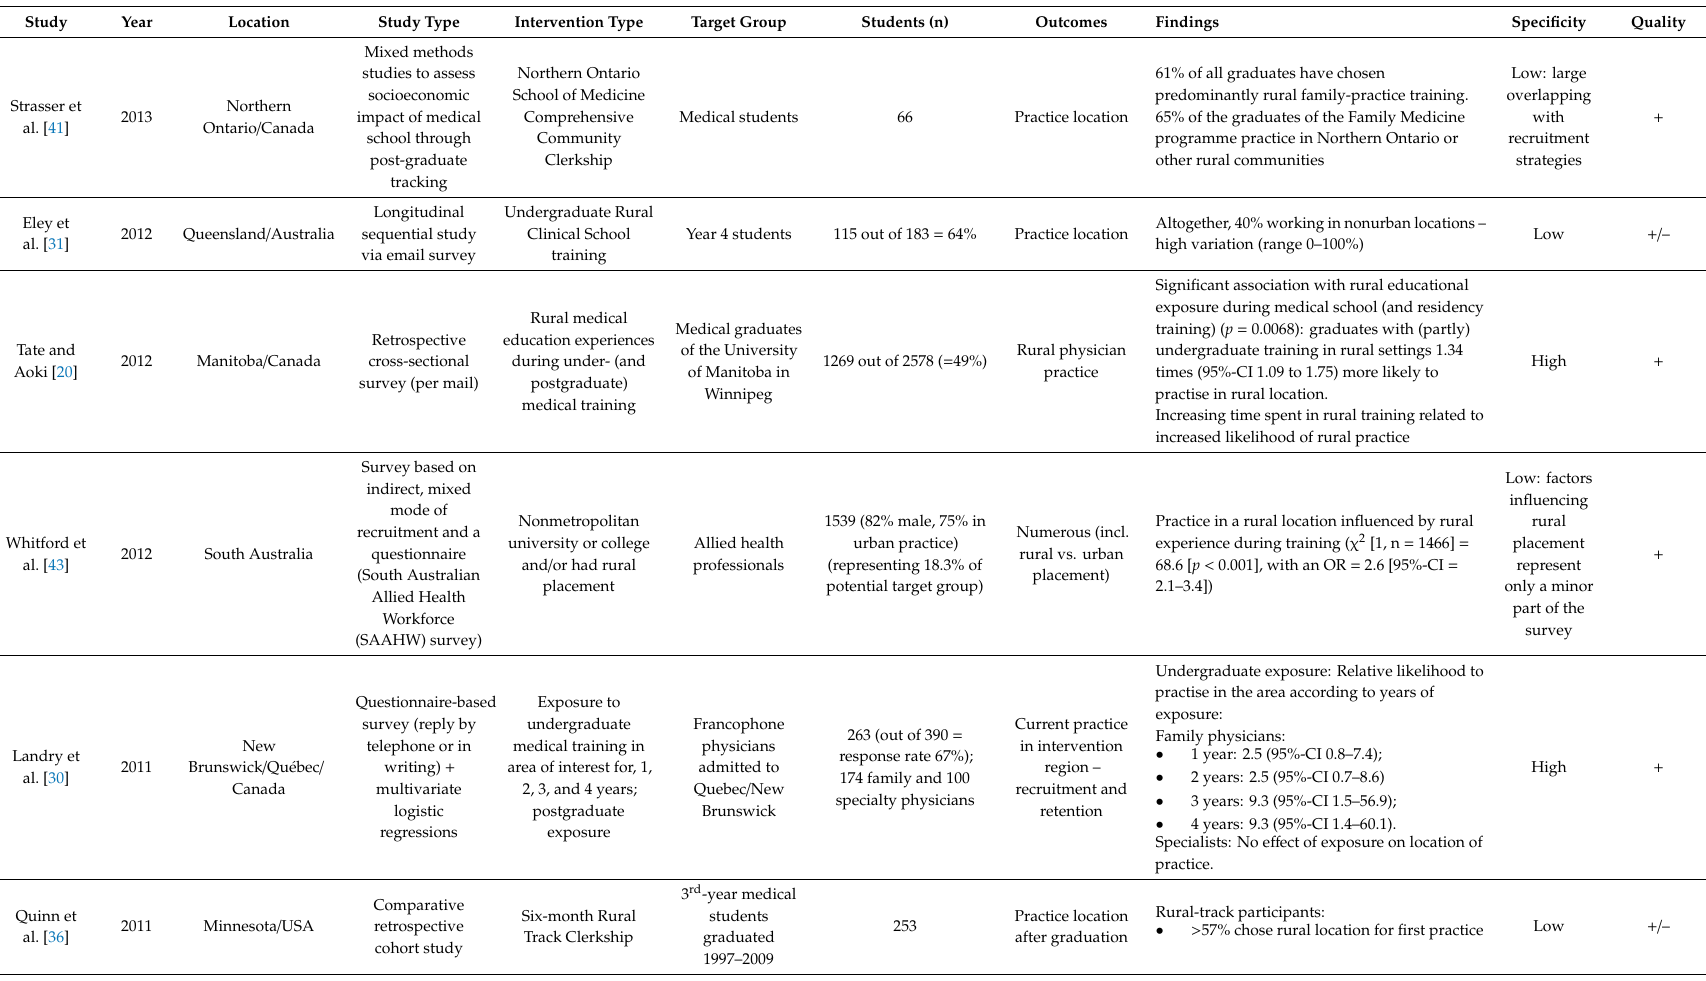
(representing 18.3% of potential target group)